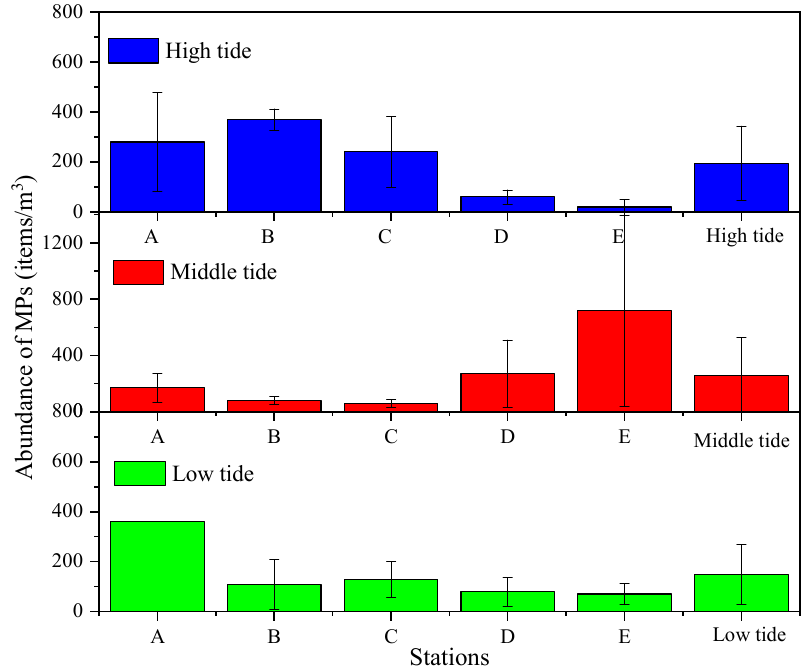
Figure 3. Abundance of MPs in the bathing seawater affected by the ebb tide.